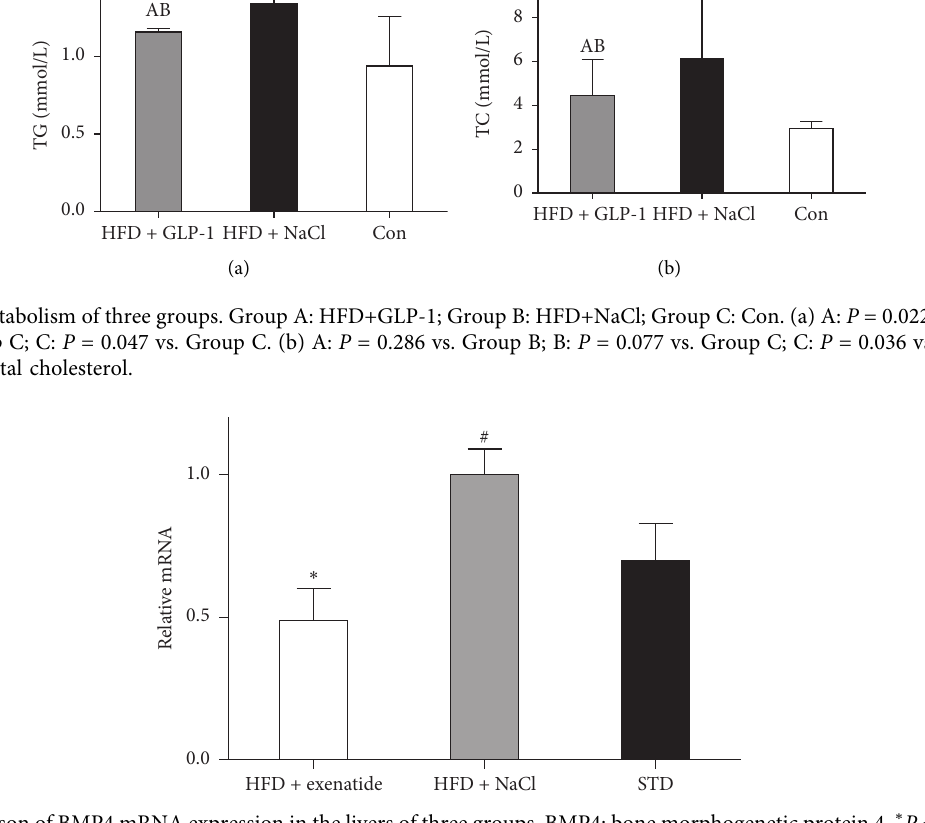
Figure 5: Comparison of BMP4 mRNA expression in the livers of three groups. BMP4: bone morphogenetic protein 4. ∗ P < 0.05 for Group A vs. Group B; # P < 0.05 for Group B vs. Group